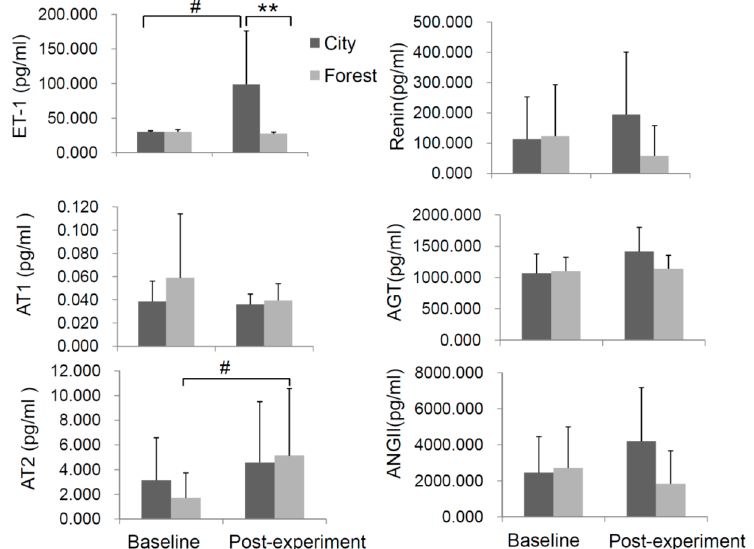
Figure 4. Effect of forest bathing on change for the endothelin-1 (ET-1) production and components of the renin-angiotensin system (RAS). Renin, angiotensinogen (AGT), angiotensin II (Ang II), angiotensin II type 1 receptor (AT1), and angiotensin II type 2 receptor (AT2) of subjects were evaluated before and after the experiment (forest group ( n = 23) and control group ( n = 10)). ** p < 0.01, # p < 0.05, analyzed by the Kruskal-Wallis test followed by the Dunn-Bonferroni test.